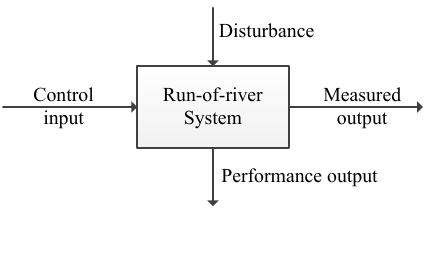
Figure 1: Functional description of run-of-river